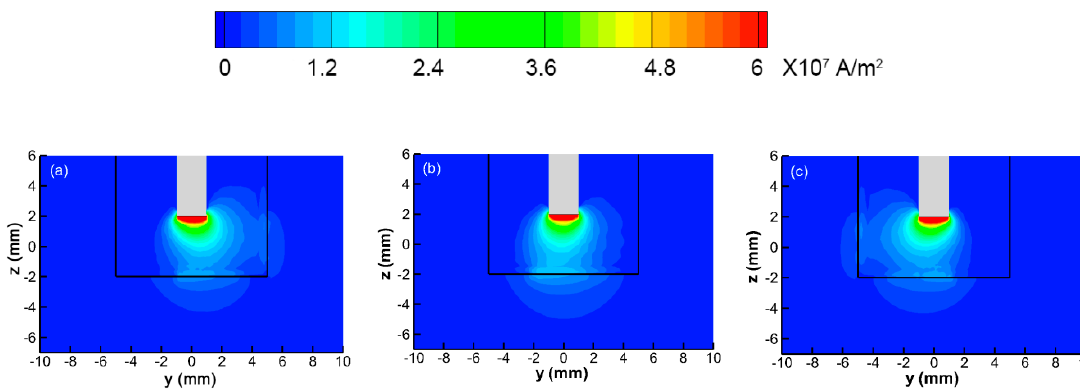
Figure 6. Current density at cross section (x = 0): ( a ) t = 0.0250 s; ( b ) t = 0.0252 s; ( c ) t = 0.027 s.